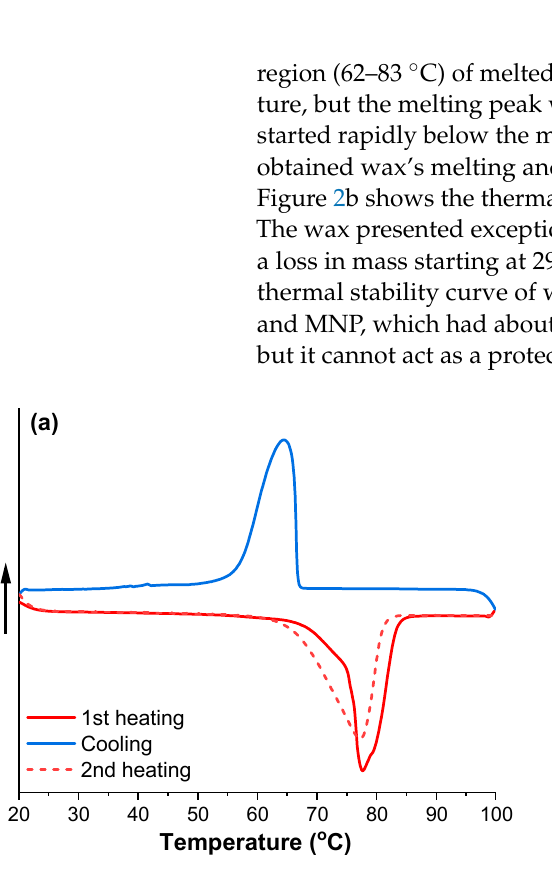
Figure 2. ( a ) Calorimetric properties of pine wax and ( b ) thermal stability of pine wax, CNP, and MNP.